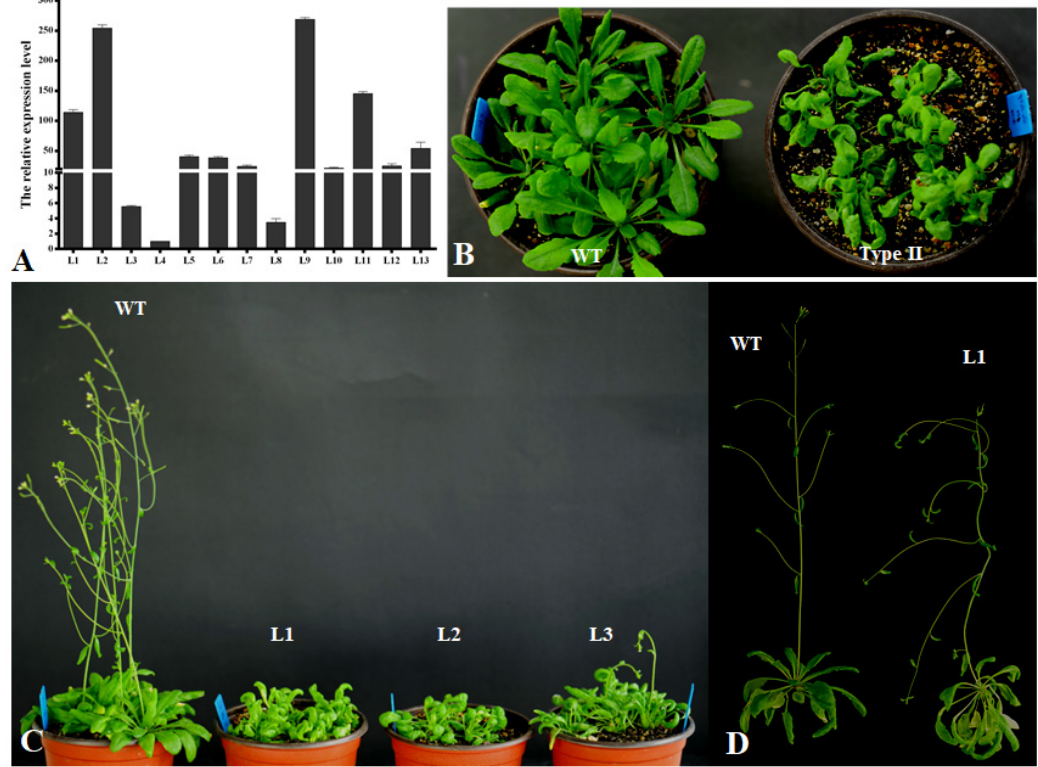
Figure 3. Curved leaf morphological feature of PsnCYCD1;1 transgenic Arabidopsis seedlings. ( A ) qRT-PCR detection of transgenic Arabidopsis . L1-13, thirteen different transgenic lines. ( B ) One-month-old transgenic seedlings under short-day condition. ( C ) Two-month-old transgenic seedlings after transferring to long-day condition. ( D ) Sixty-day-old flowering wild type Arabidopsis and 95-day-old flowering transgenic plants. WT, wild type; Type II, Type II transgenic seedlings; L1-3, three independent transgenic lines.